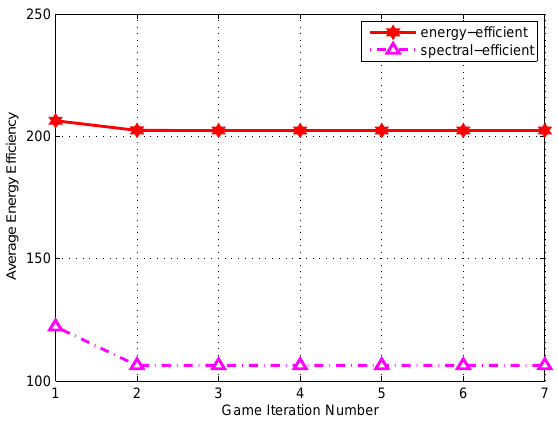
Figure 4: The average energy efficiency of cellular links corresponding to the number of game itera- tions ( N = 3 , K = 3 , M = 64 , p l = ˜ p l = 200 i,max k,max mW, R l = 0 . 1 bit/s/Hz, R l = 0 . 5 bit/s/Hz, i,min k,min 1000 simulations). Table 1: Simulation Parameters. Parameter Value Cell radius 500 m Maximum D2D distance 25 m